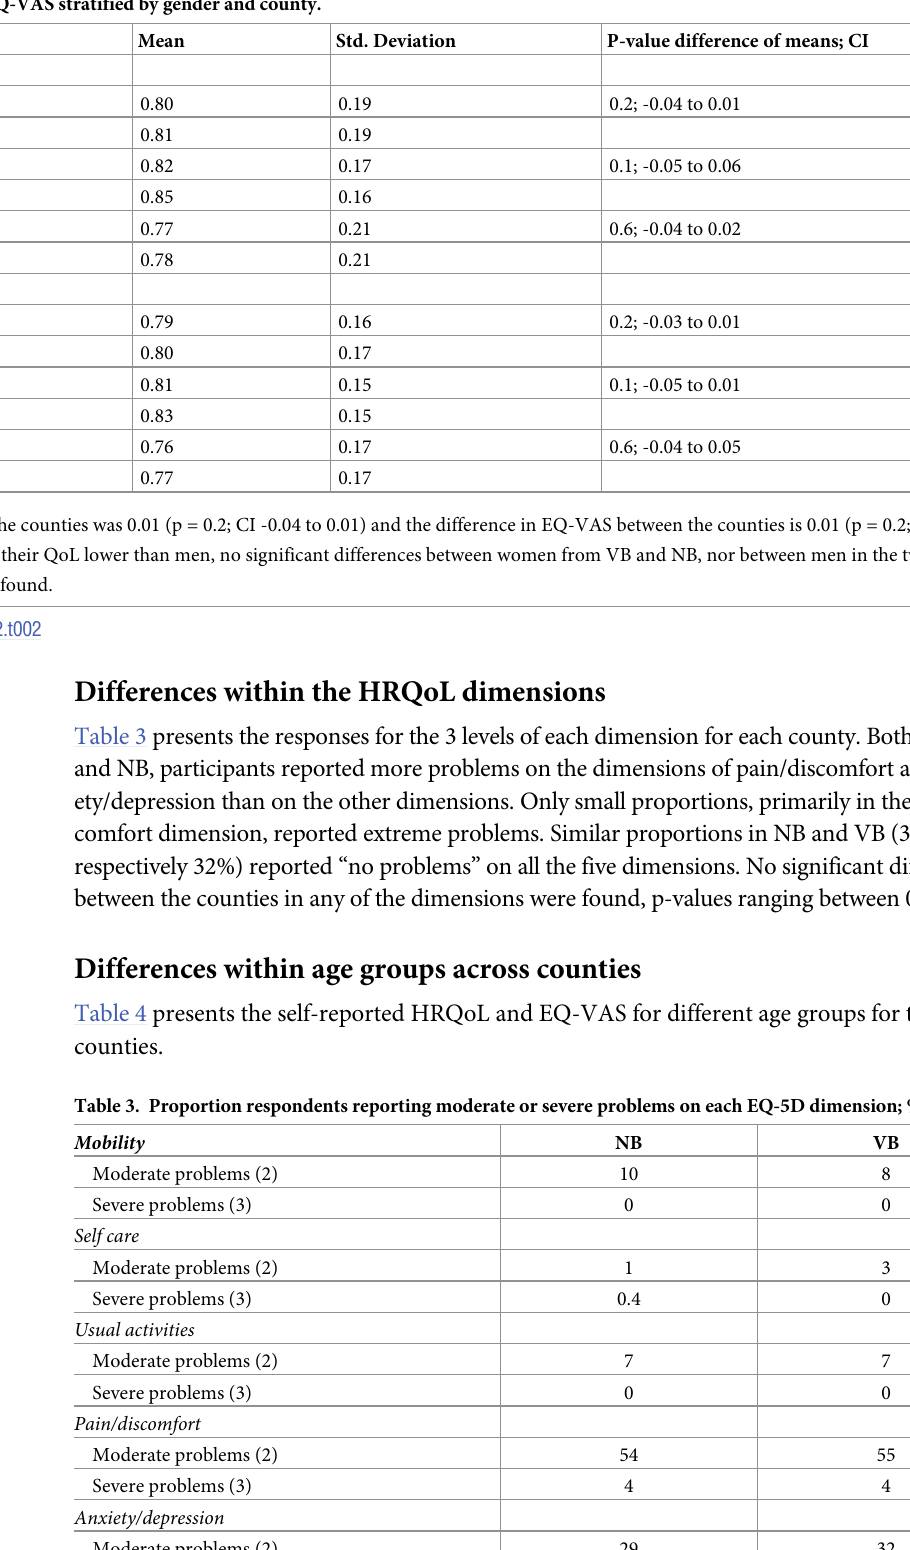
Table 2. HRQoL by EQ-5D-index and EQ-VAS stratified by gender and county. County Mean Std. Deviation